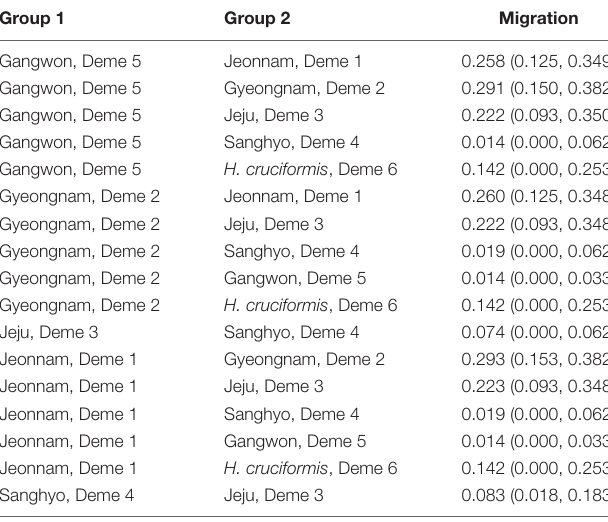
TABLE 4 | Results for tests of recent bottlenecks Habenaria linearifolia and Habenaria cruciformis populations. Population P (Sign test)